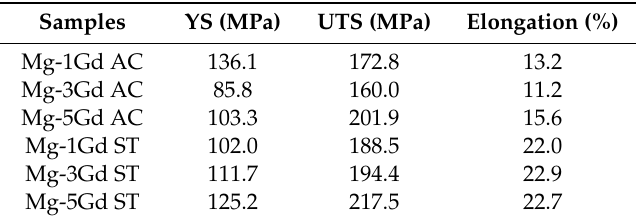
Figure 6. The stress–strain curves of the Mg-Gd alloys under di ff erent conditions. Figure 6. The s tress–strain curves of the Mg-Gd alloys under different conditions. Table 4. The mechanical properties of Mg-xGd